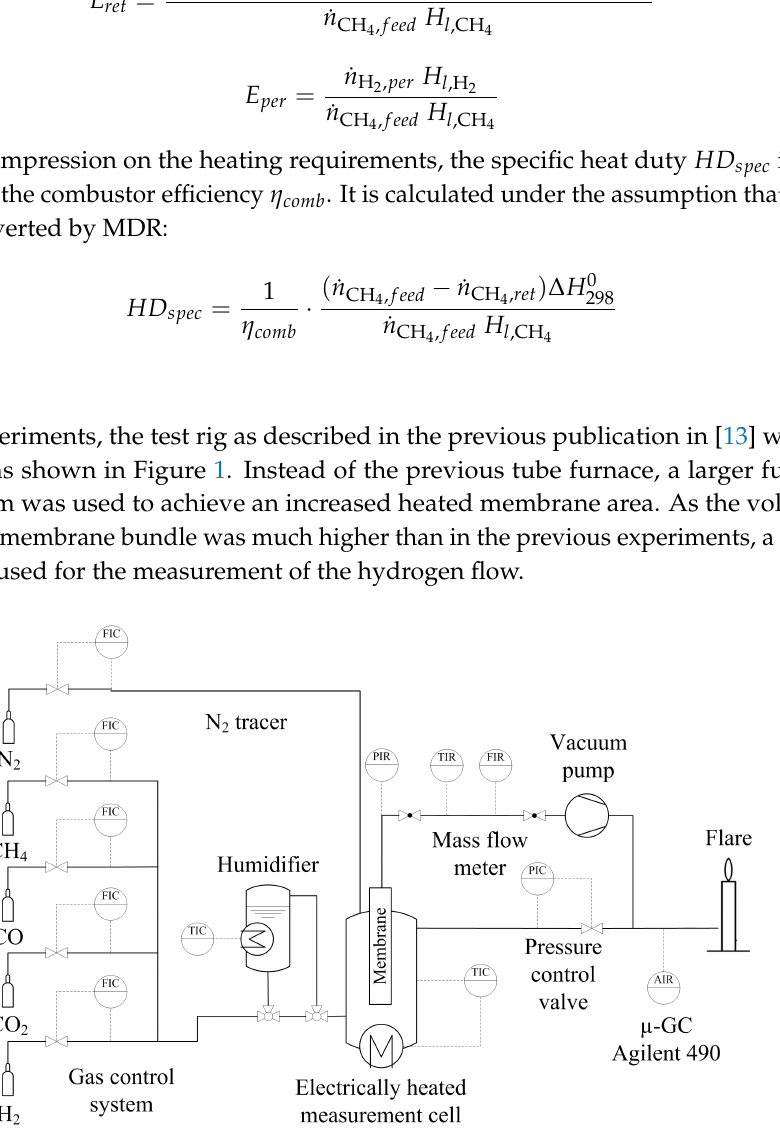
Figure 1. Piping and instrumentation diagram of the membrane test rig for membrane bundle